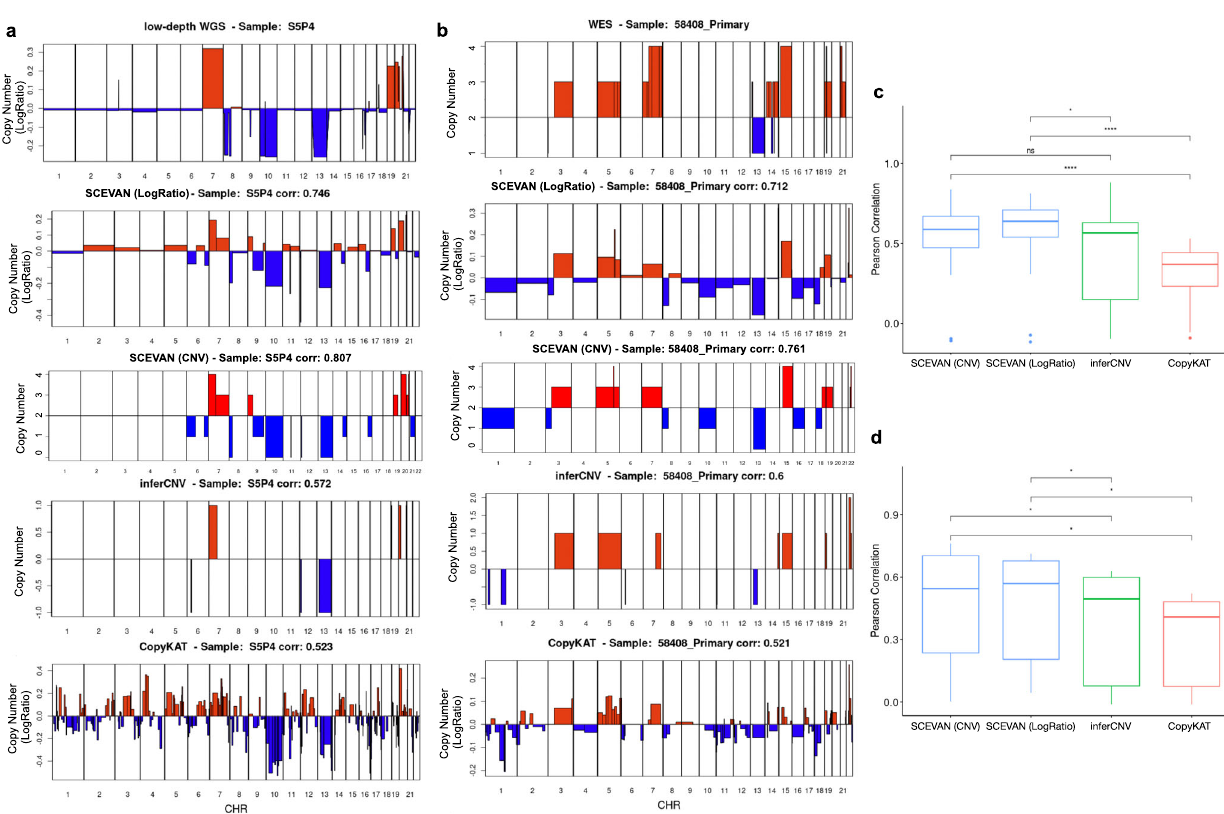
Fig. 3 | Benchmark of inferred copy number pro fi le. a , b Copy number pro fi le inferred with SCEVAN (segment mean (LogRatio) and CNV status), inferCNV, CopyKAT, the corresponding ground truth from low-depth WGS of sample S5P4 22 andfromWESofsample58408Primary 17 . c , d Boxplotsshowthemedianascenter, thelowerandupperhingesthatcorrespondtothe25thandthe75thpercentile,and whiskersthatextendtothesmallestandlargestvaluenomorethan1.5*IQR.Values that stray more than 1.5*IQR upwards or downwards from the whiskers are con- sidered potential outliers and represented with dots. Signi fi cance was computed by a two-sided Wilcoxon signed-rank test (ns: P value>0.05, * P